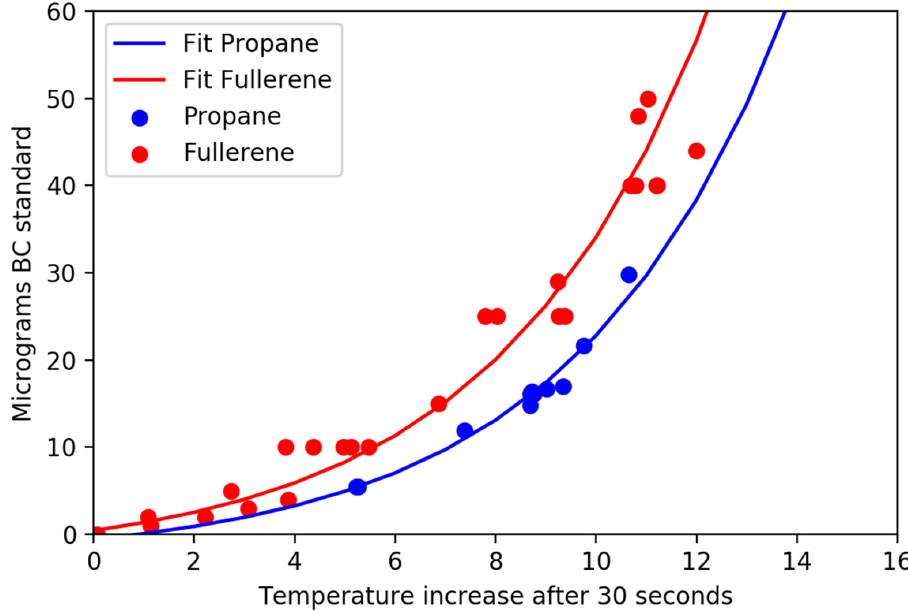
Figure 5. Temperature to BC mass relationship for two different types of soot, fullerene soot (orange), or propane flame soot (blue).